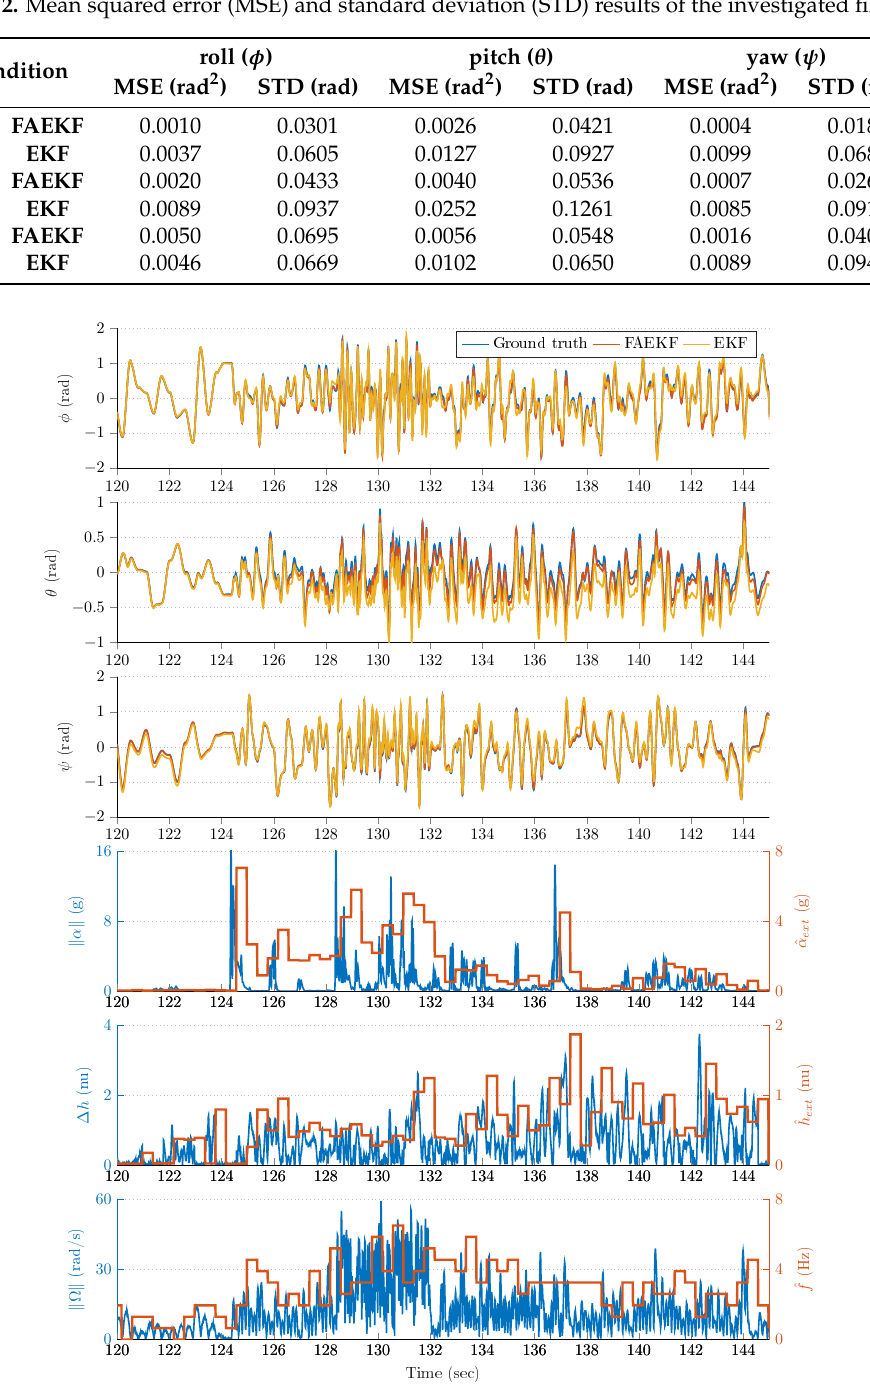
Figure 9. Second time slot from the